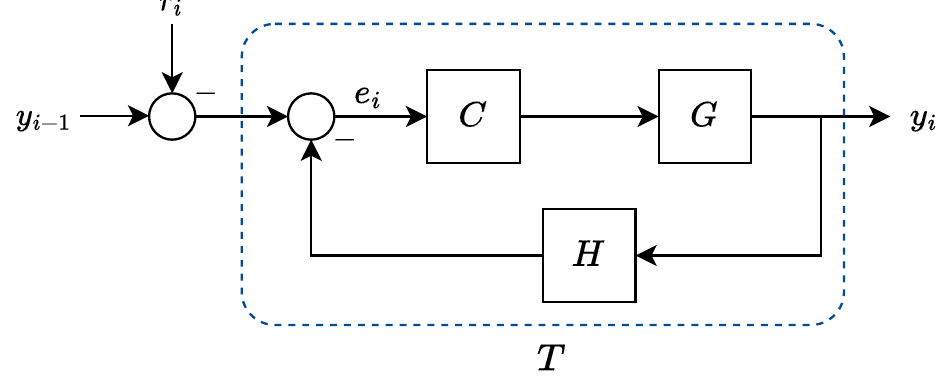
Figure 2. Feedback control loop for the position y i in each vehicle, assuming ideal communication. The time-headway spacing policy is included in H ( z ) .